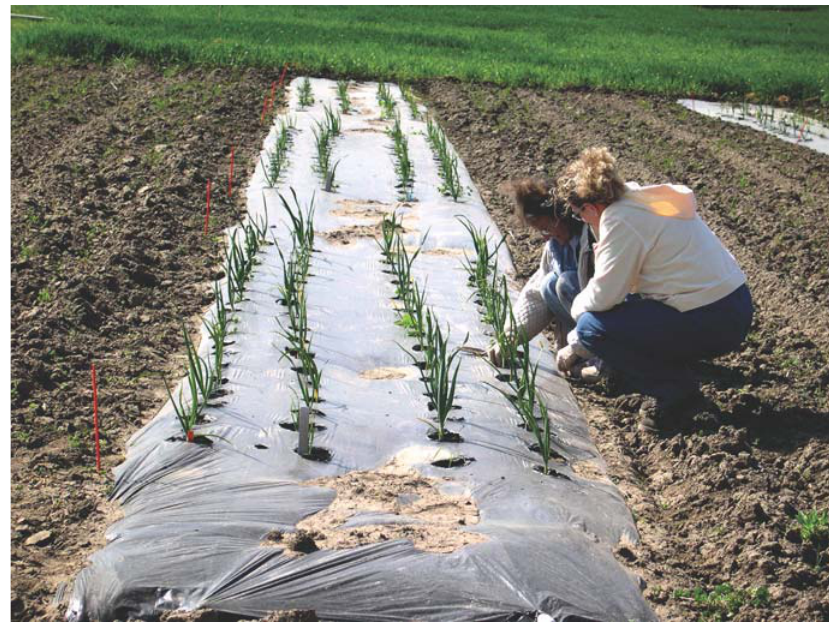
Figure 2. Regenerating